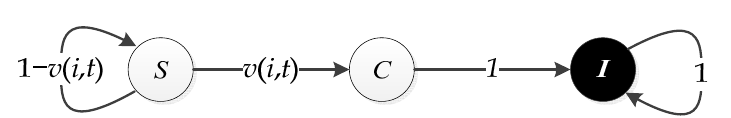
Figure 3. Microscopic view of a sensor individual in propagation.